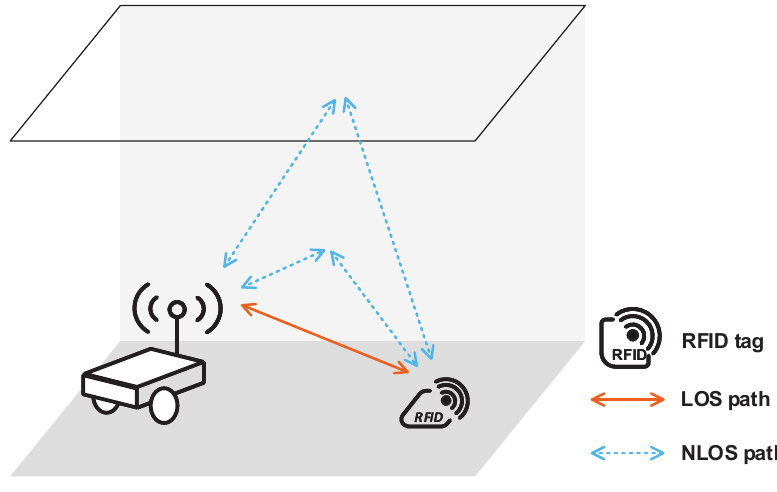
Figure 3. Multipath propagation scenario of the indoor autonomous vehicle navigation